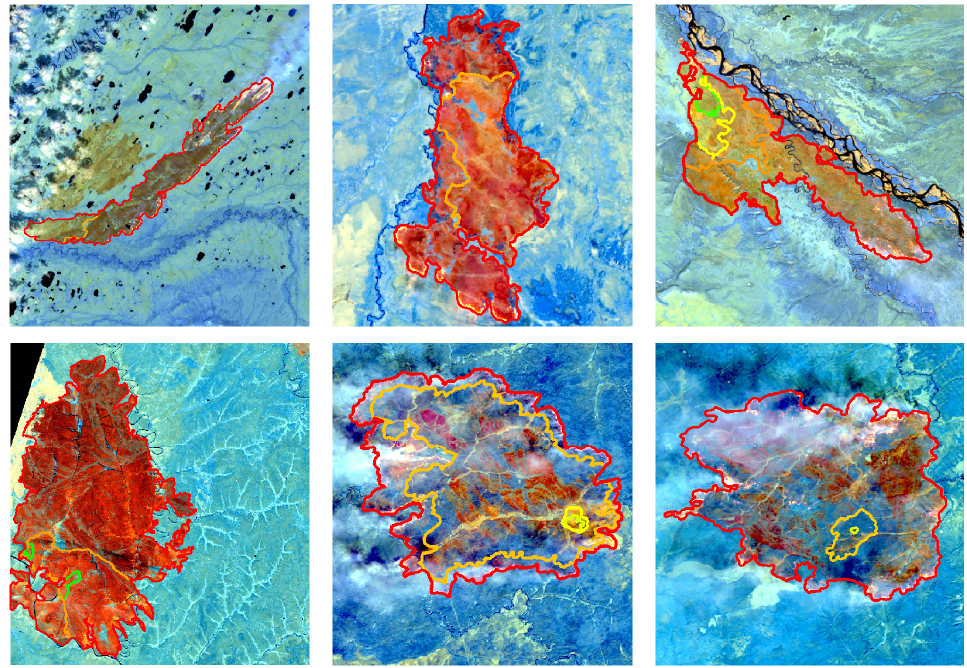
Figure 11. Examples of typical individual fires on different landscape structures. The images are Sentinel-2 bands B12, B11, B8A as RGB; the polygons of different colors represent successive fire boundaries as mapped by our algorithm.